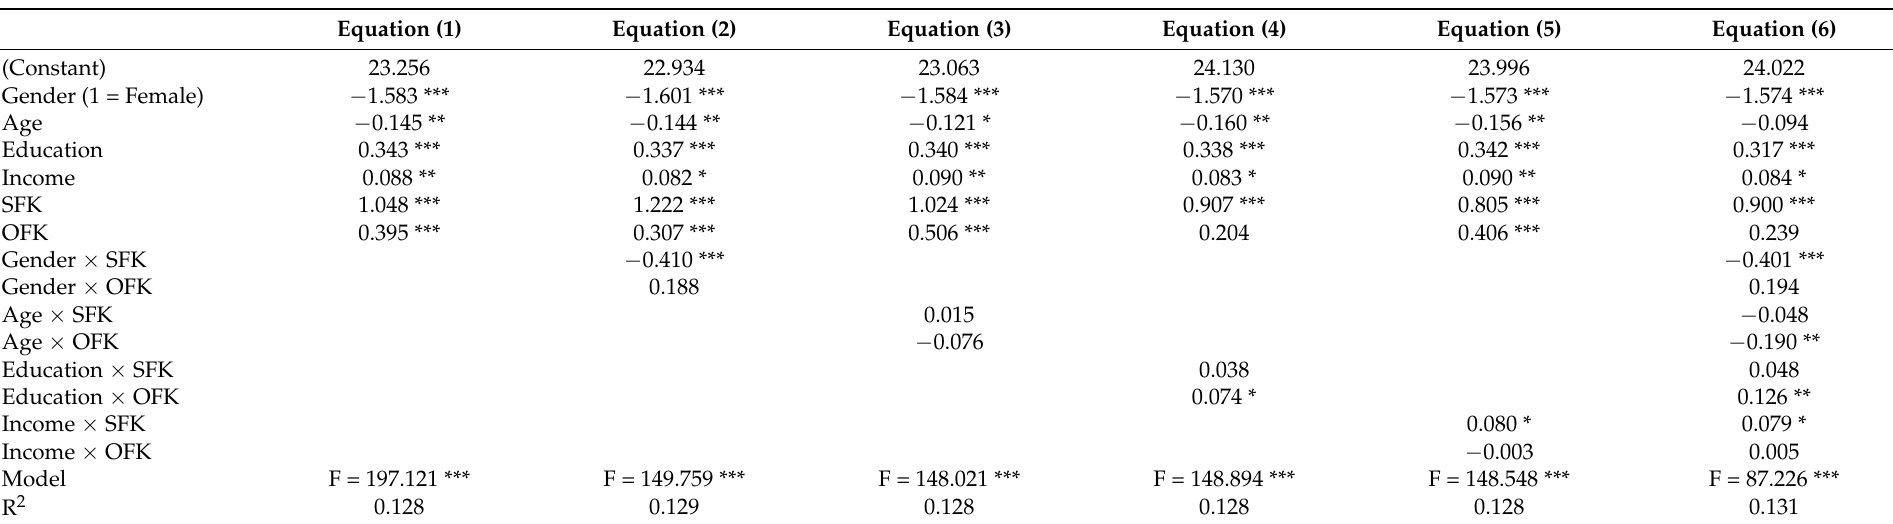
Table 7. Regression Results Showing the Moderation Effect of Subjective and Objective Financial Knowledge through Age, Education, and Income on Investment Risk Tolerance (N =